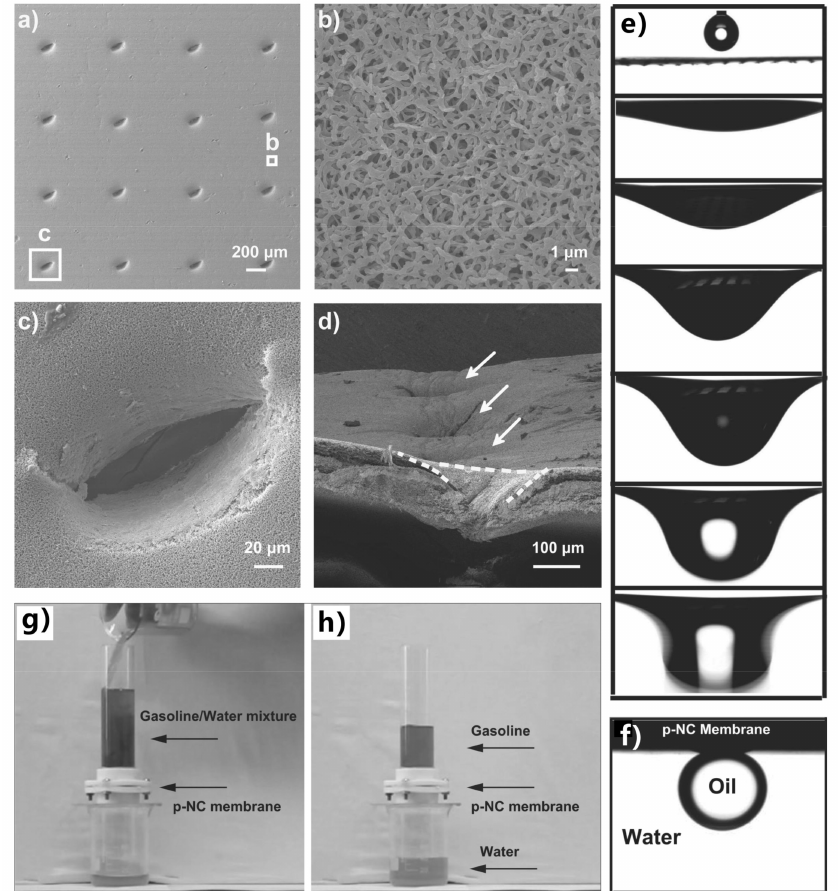
Figure 15. Achievement of the oil/water separation based on a dual-scaled porous nitrocellulose membrane. ( a ) SEM image of the dual-scaled porous nitrocellulose membrane. ( b ) Morphology of the inherent pore structure of the nitrocellulose substrate composed of interconnected nanofibers. ( c ) Top-viewed and ( d ) cross-sectional microstructure of the perforated hole on the nitrocellulose membrane. ( e ) Process of water droplets wetting and permeating through the porous nitrocellulose membrane. ( f ) A drop of light oil on the membrane underwater. ( g ) Pouring the mixture of gasoline and water into the separation device composed of the perforated membrane. ( h ) After separation. Reprinted with permission from ref. [262]. Copyright 2013, WILEY-VCH Verlag GmbH & Co.